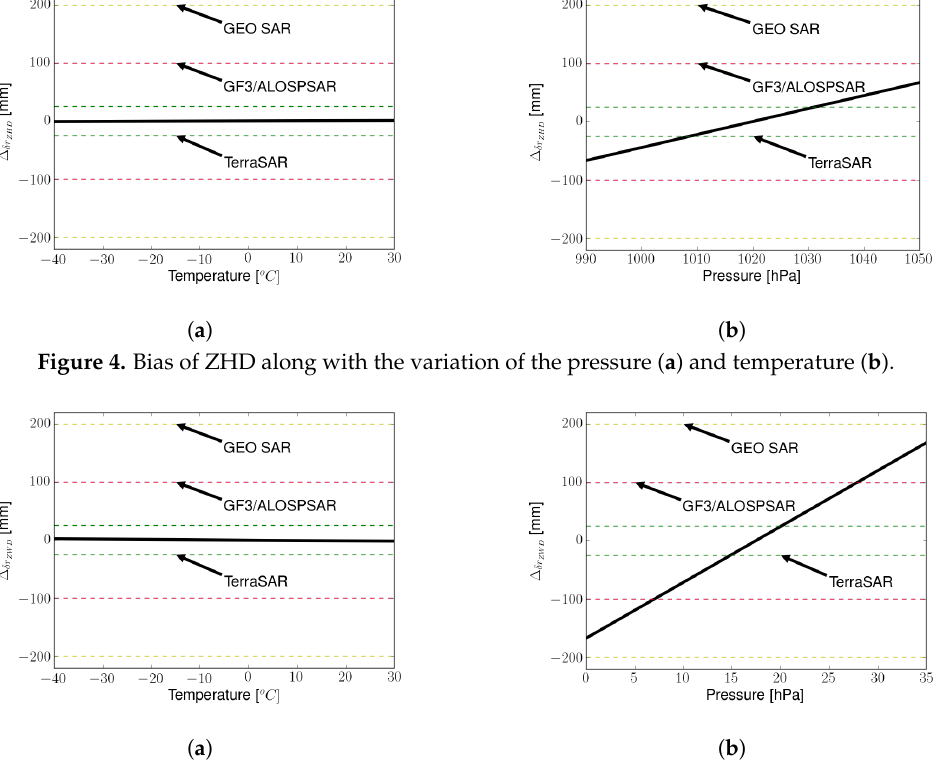
Figure 5. Bias of ZWD along with the variation of the temperature ( a ) and water vapor pressure ( b ). Table 2. Systematic parameters of typical spaceborne